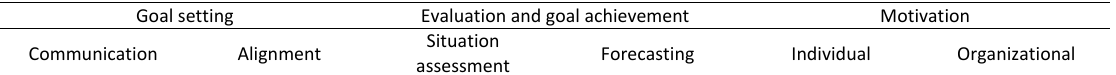
Table 1: Classification of performance goals (Samsonowa, 2012)